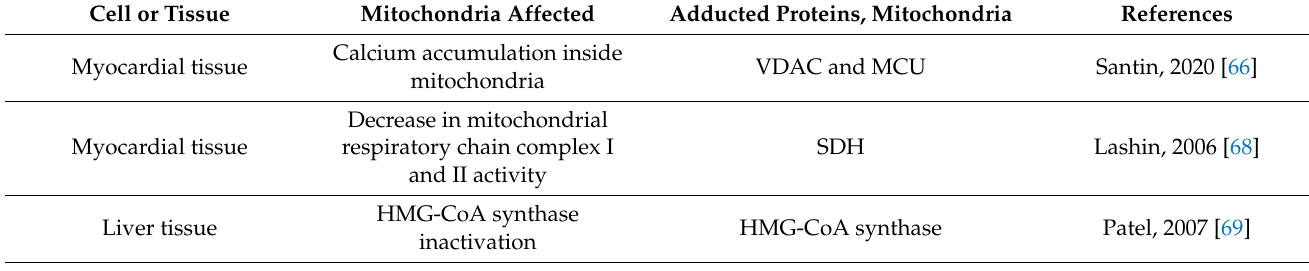
Table 1. Major studies identifying the role of 4-HNE in different mitochondrial